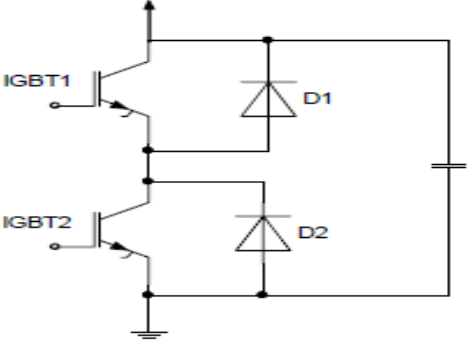
Figure 19. Electrical diagram of the inverter arm.